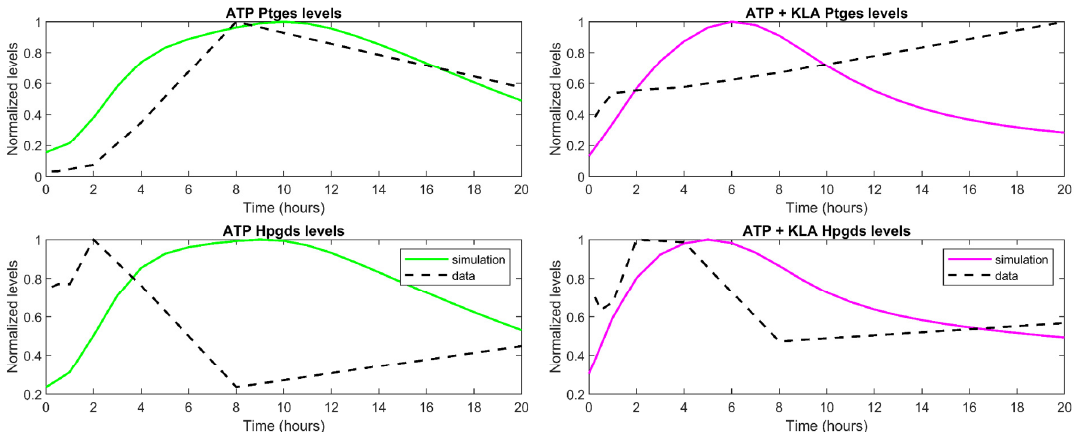
Figure 5. The behavior of the scaled cybernetic model enzyme level simulations (green in ATP stimulated case and magenta in KLA primed, followed by ATP stimulated case) generally match the trends of the scaled gene expression values (black dashed lines) for Ptges and Hpgds/Ptgds2 pathways in (left) ATP and (right) combined KLA primed ATP stimulated treatments.